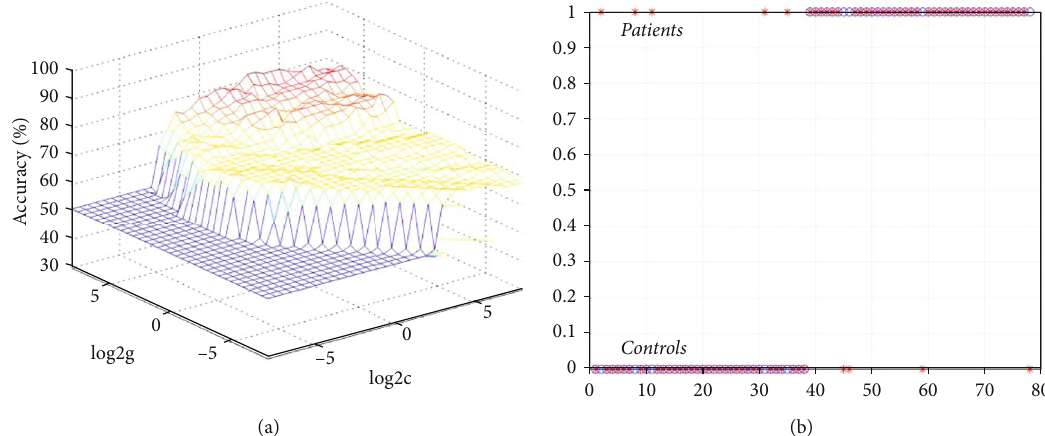
Figure 3: Visualization of SVM results for discriminating patients from controls using the degree values of the left thalamus. (a) 3D view of the classi fi ed accuracy with the best parameters. (b) Classi fi ed map of the degree values of the left thalamus. log 2 c and log 2 g mean the range and step size of the given parameters c and g ( c and g are the parameters of the kernel functions in SVM training). The fi gure in (b) means the sensitivity and speci fi city of the SVM model. The horizontal axis conveys the predicted classi fi cation of each subject, and the vertical axis conveys the correct classi fi cation of each subject. SVM =support vector